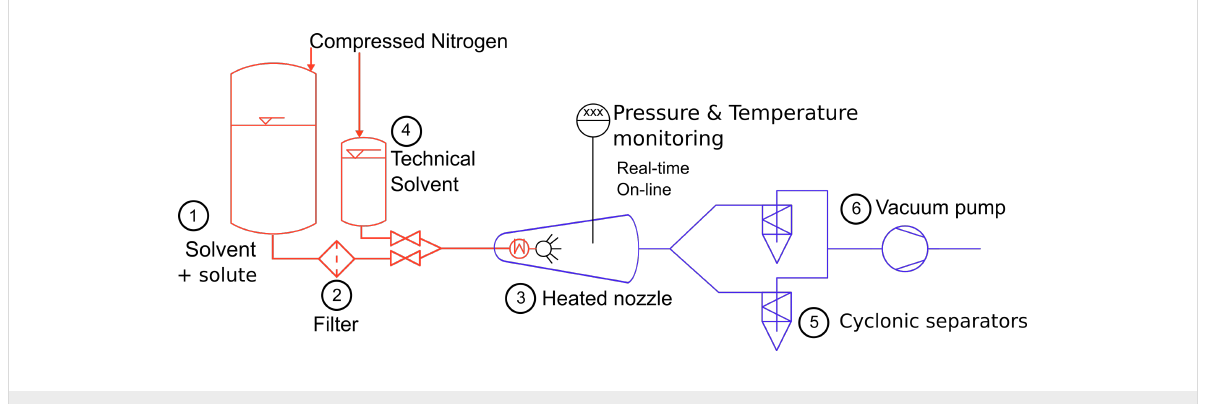
Figure 3: SFE installation as patented and used in this present work